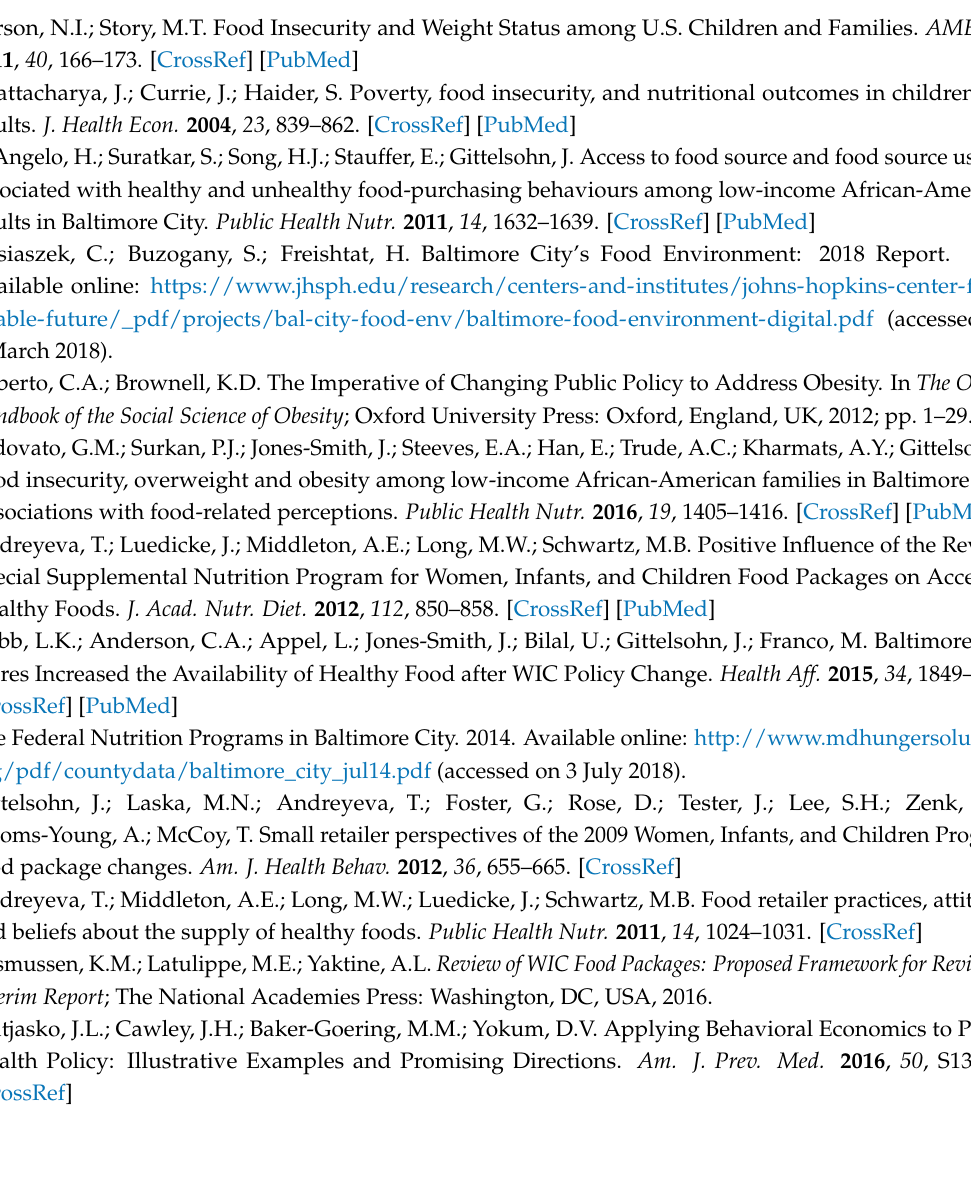
intervention and control stores, Table S1: Food groups and individual food products classified according to WIC food products, Table S2: Changes in the stocking of WIC-eligiblefoods, total unit sales of WIC-eligiblefoods to all customers, and unit sales of WIC-eligiblefoods to WIC clients in intervention stores following implementation of two, three, and four BE strategies, by WIC food